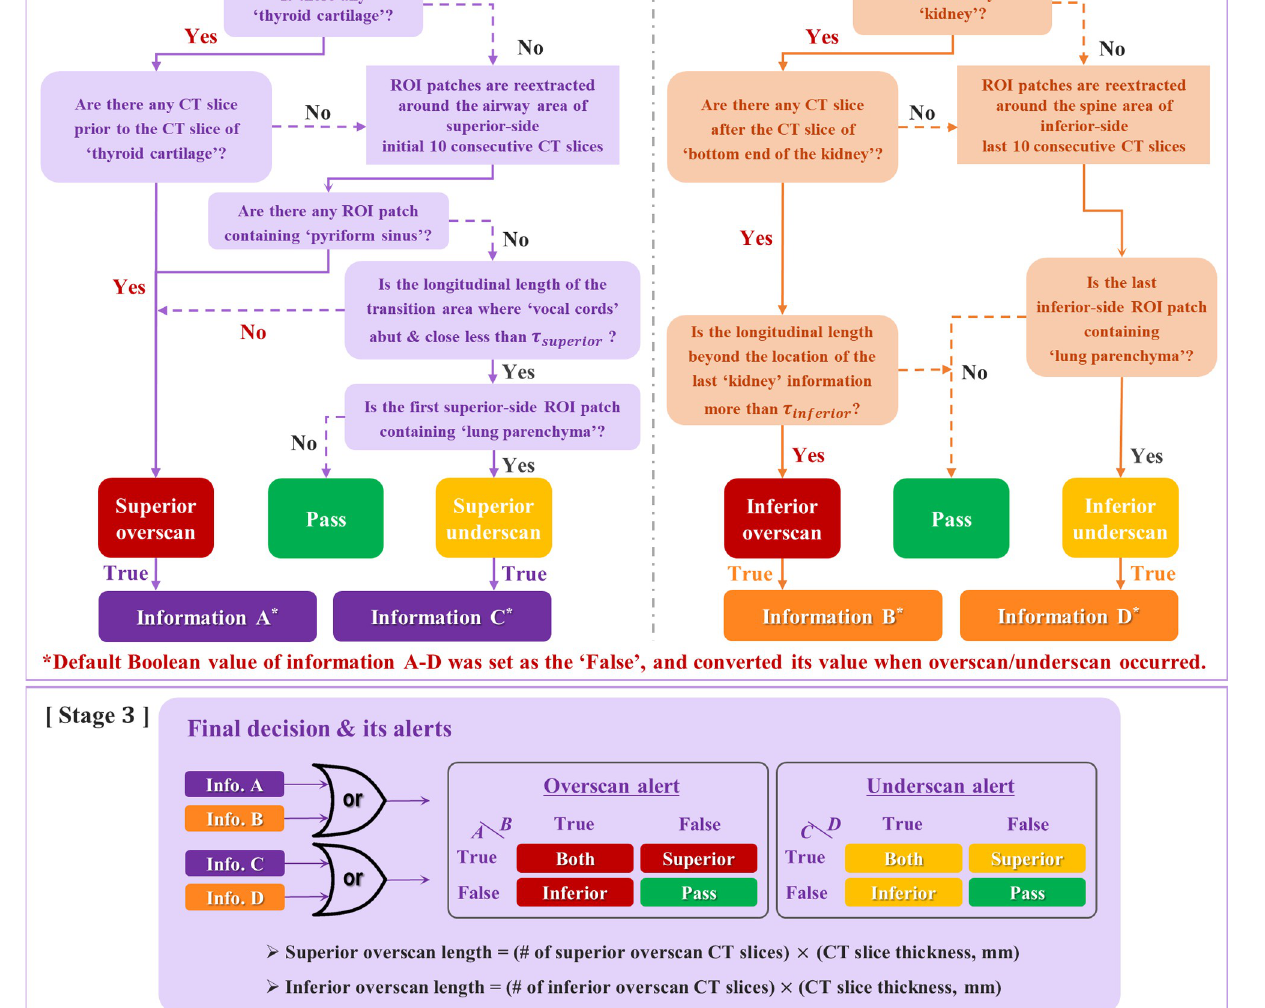
PLOS ONE | https://doi.org/10.1371/journal.pone.0275531 September 29, 2022 5 /